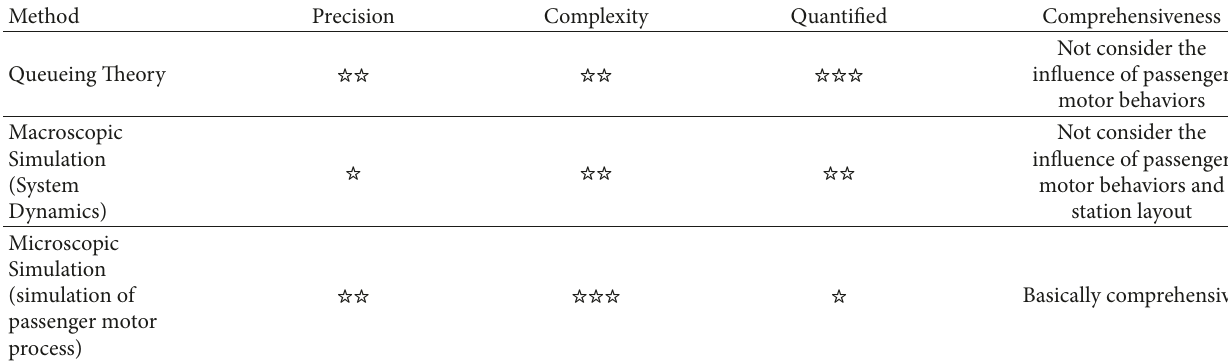
Table 1: Calculation methods for load capacity of URT